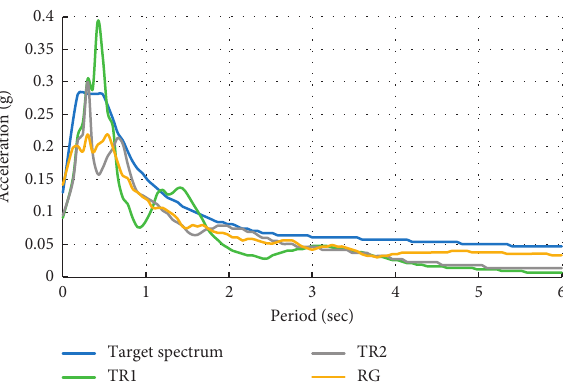
Figure 16: Design spectra and scaled earthquake spectra.